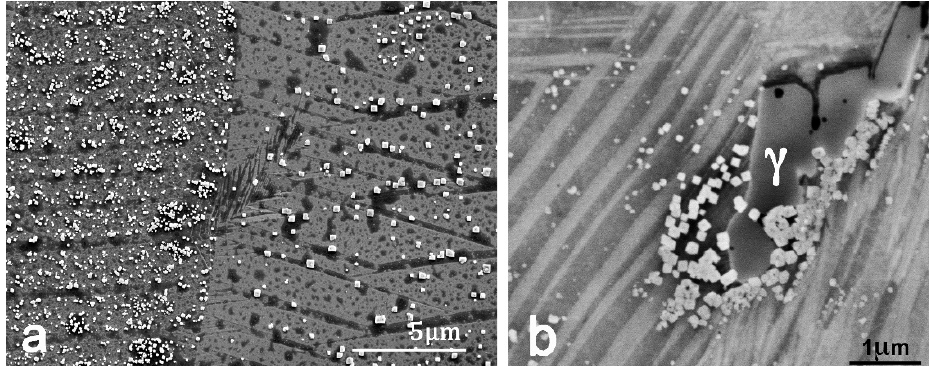
Figure 7. ( a ) SEM–SE image of as–LPBF DM–3 sample, with a distribution of small cuboidal precipi- tates (<<1 µ m). ( b ) SEM–SE image of as–LPBF DM–4 sample showing the same cuboidal precipitates and a bigger γ precipitate. Martensites are clearly seen in both